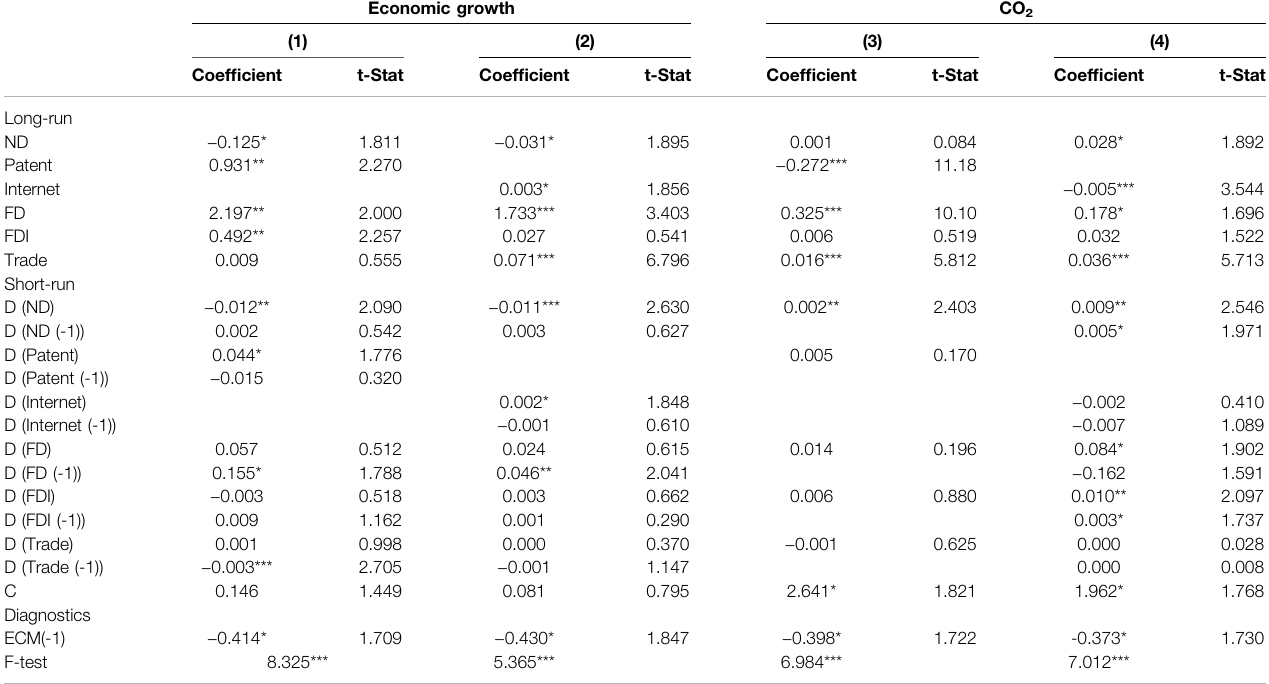
Economic growth